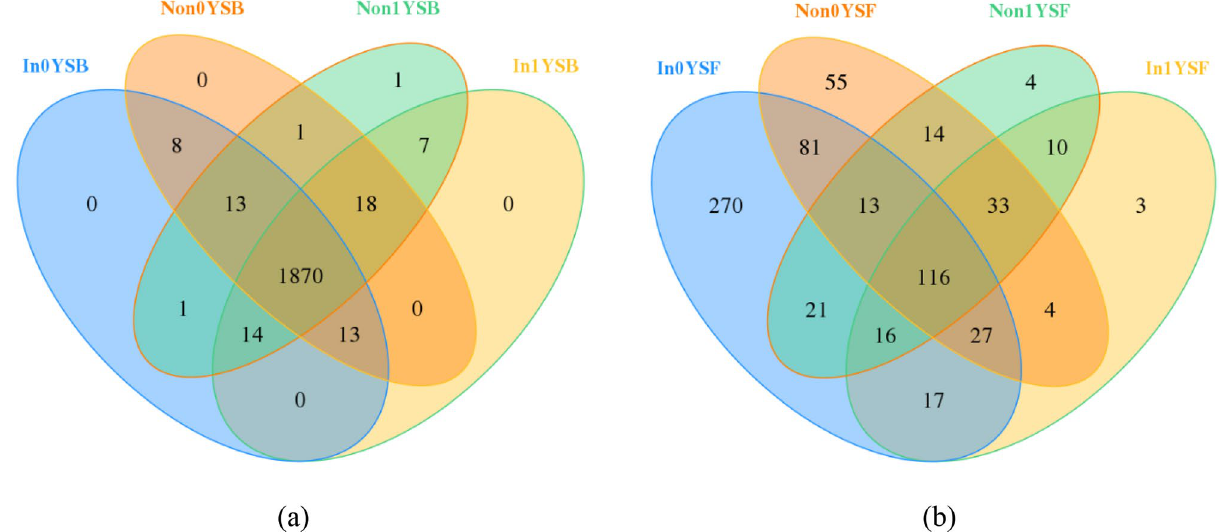
Figure 1. The VENN diagrams of the four samples according to bacterial ( a ) and fungal ( b ) diversity. Non represents non-inoculated with R. intraradices . In represents inoculated with R. intraradices . 0Y and 1Y represent 0 year and 1 year of continuous cropping, respectively. SB represents bacteria in rhizosphere soil. SF represents fungi in rhizosphere